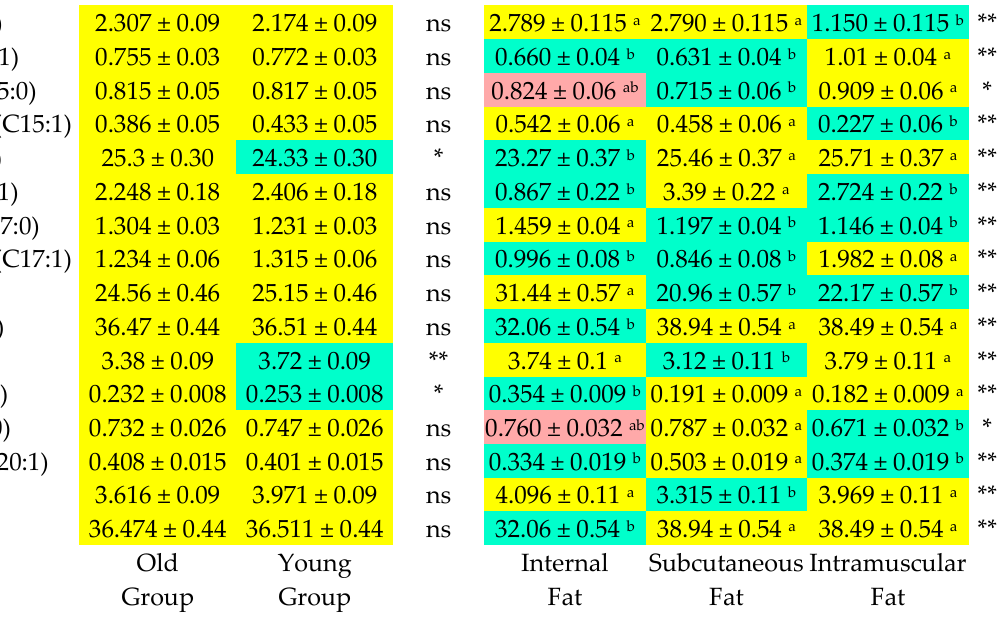
Figure 1. Heatmap plot of fatty acids composition of different fat types in carcasses of bulls depending on slaughter age. *: p < 0.05; **: p < 0.01; ns: non ‐ significant; a,b : Values in rows with different letters and colors differ sig.